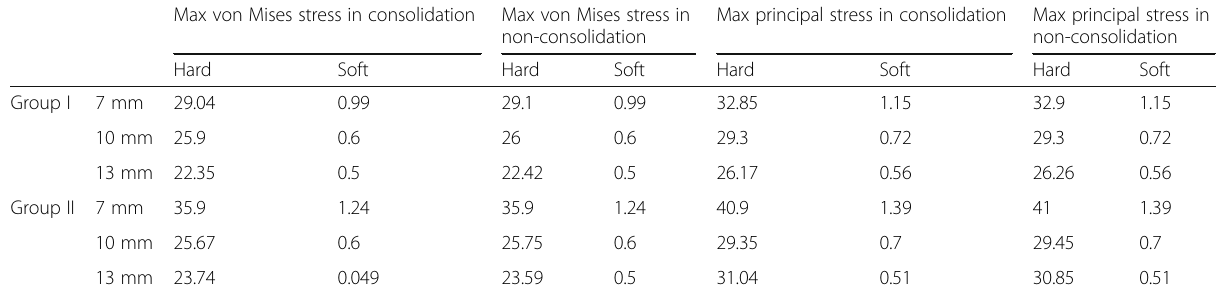
Table 7 Stresses on the hard bone and soft bone around the implant area in consolidated and non-consolidated in group I and group II models (Mpa)